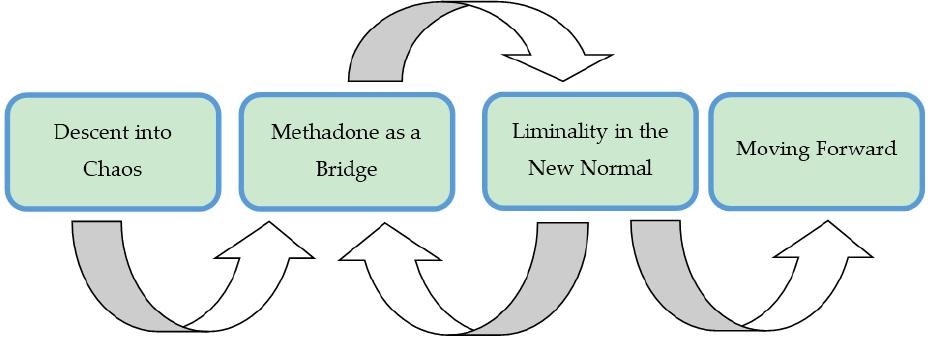
Figure 1. Participants’ experiences of MMT.